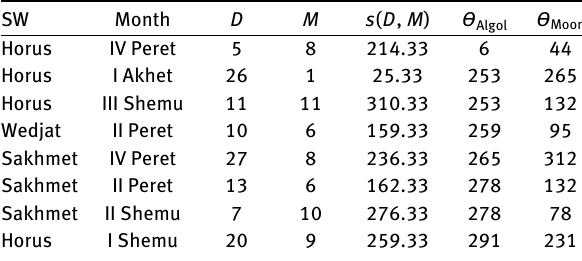
Table 2. “SSS” prognosis texts mentioning Horus, Wedjat or Sakhmet. Notations are as in Table